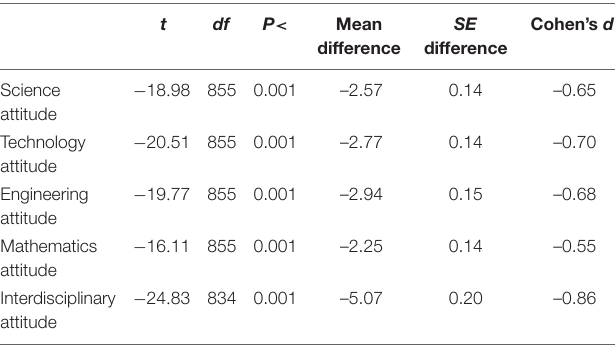
TABLE 3 | Self-reported change in student attitude toward four STEM subjects and interdisciplinary